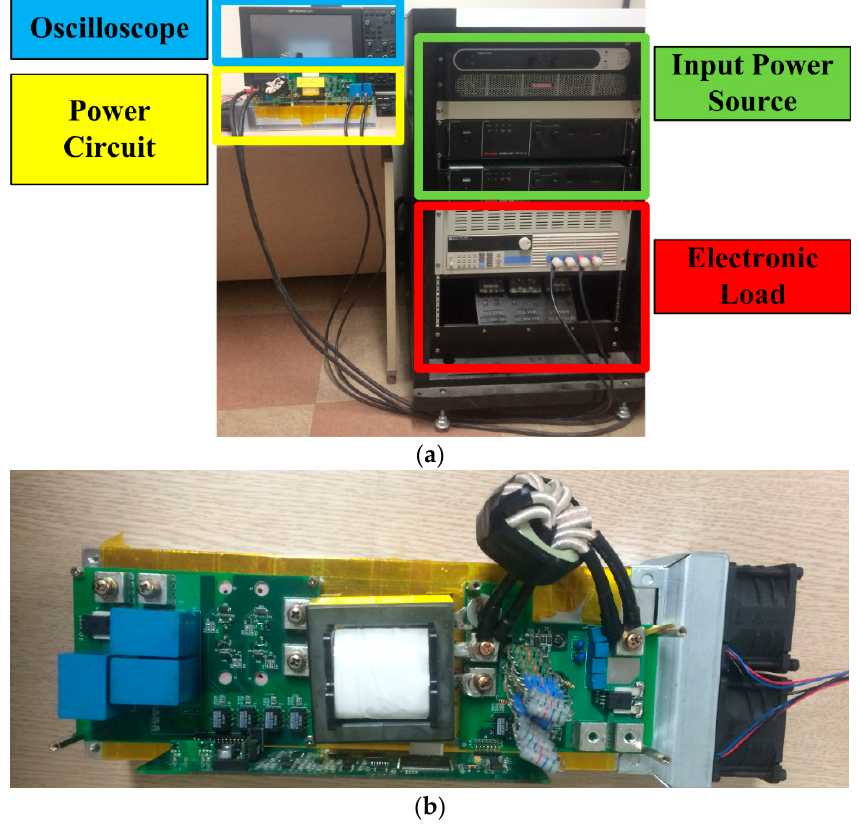
Figure 11. ( a ) Configuration of the experiment setup; ( b ) prototype of a power circuit.